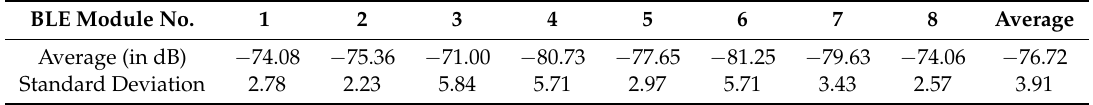
Table 3. Average RSSI values.